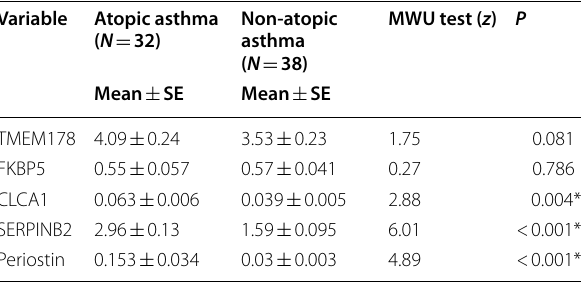
Table 6 Comparison between atopic and non-atopic asthma regarding nasal epithelial cell genes